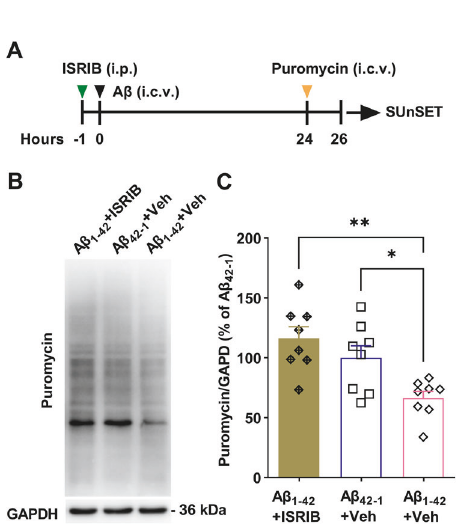
Fig. 5 ISRIB prevented the disruption of protein synthesis induced by A β 1 – 42 . A Experimental timeline: Rats received systemic and i.c.v. injections under iso fl urane anesthesia. ISRIB (2.5 mg/kg, i. p.) was administrated 1 h before A β injection (i.c.v., 10 μ L each side). Rats were re-anesthetized 24 h after A β injection with iso fl urane and received an i.c.v. injection of puromycin (5 μ L each side, 10 μ g/ μ L). Brain samples were collected 2 h after puromycin injection. B Protein extracts were separated by electrophoresis and analyzed by western blot with antibody to puromycin. GAPHD immunoblot is shown as a loading control (bottom). C Levels of newly synthesized proteins labeled with puromycin were signi fi cantly lower in A β 1 – 42 + Veh group compared with A β 42 – 1 + Veh group ( n = 8, P = 0.0386, one-way ANOVA). In ISRIB treatment group, protein synthesis was markedly restored ( n = 8, P = 0.0018, A β 1 – 42 + ISRIB compared